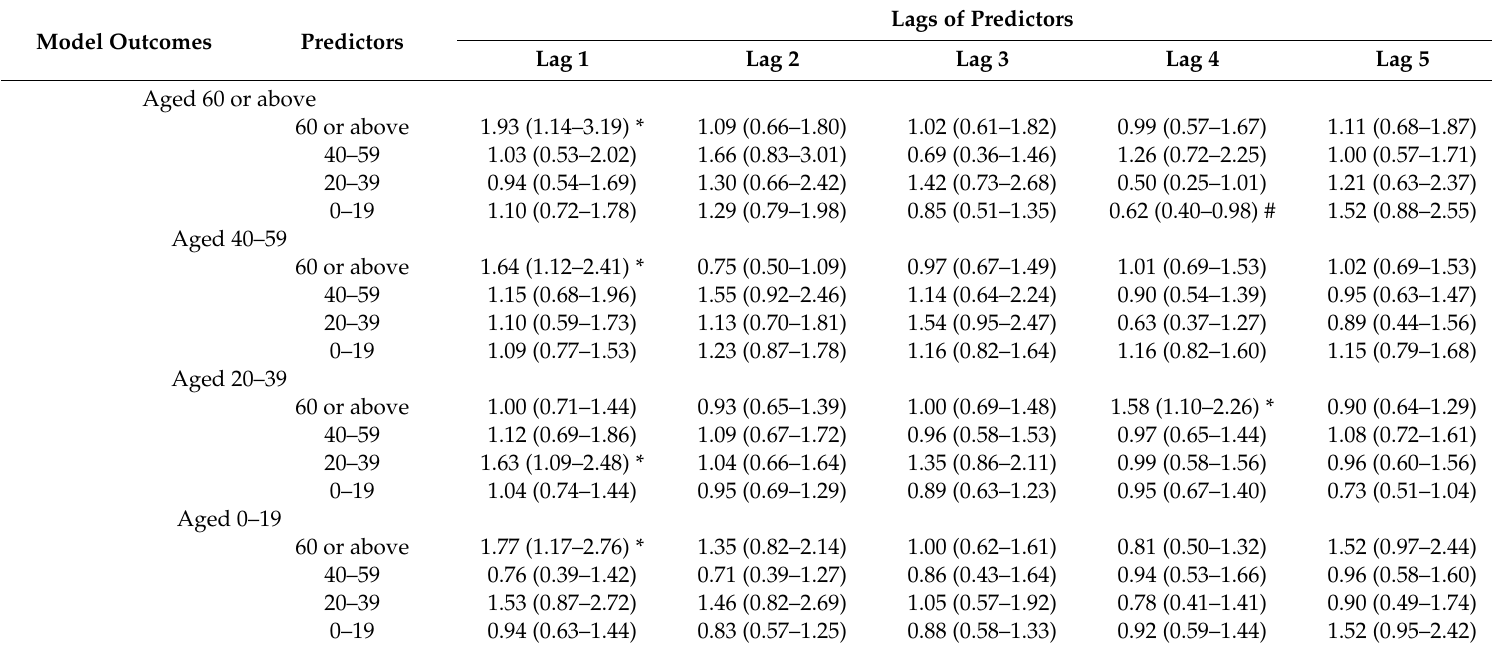
Table A1. Risk interactions in coronavirus infection across age groups based on negative binomial models, COVID-19, South